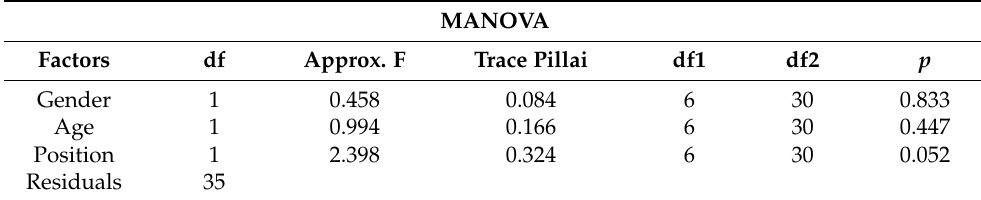
Table 8. Results of the main effect of MANOVA.